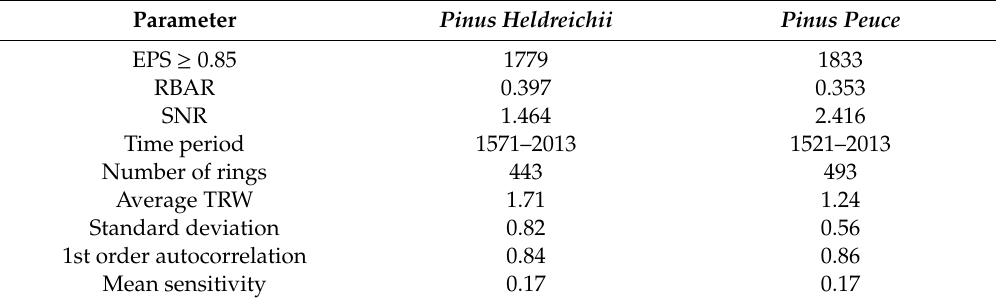
Table 2. Basic descriptive statistics for both TRW chronologies. RBAR was calculated as the average value of the 30-year moving RBAR for the period in which EPS ≥ 0.85. Parameter Pinus